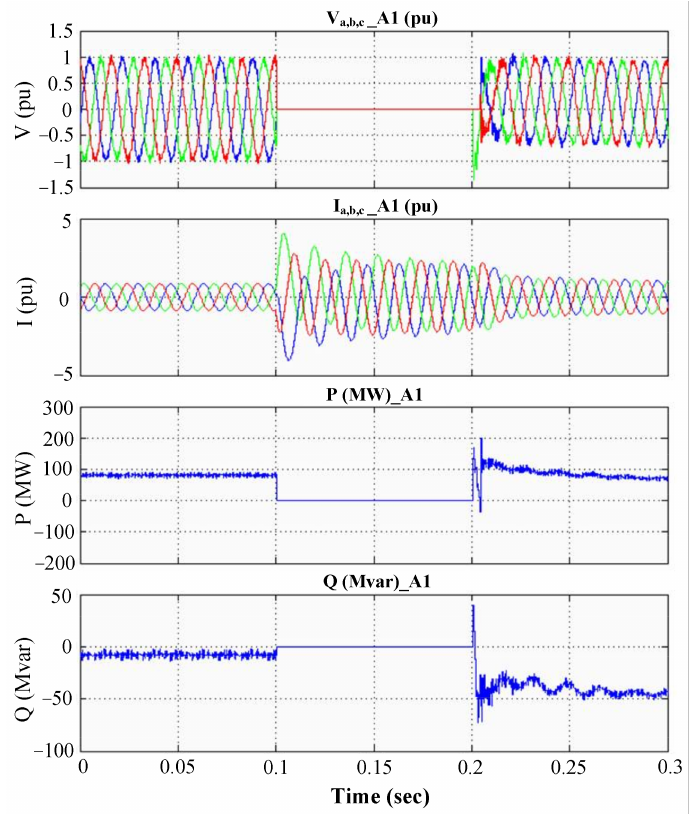
Figure 7. Responses of voltage, current, and real and reactive power on bus